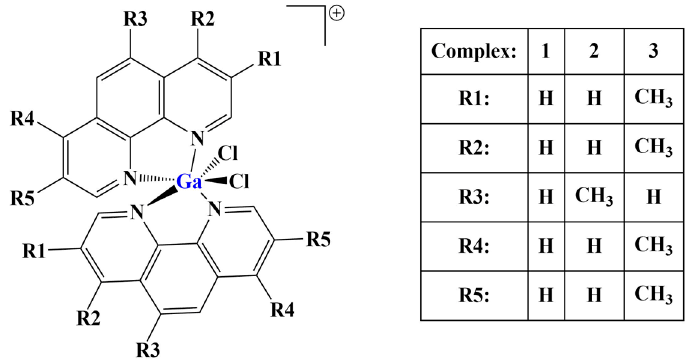
Figure 23. The complexes presented in [93].